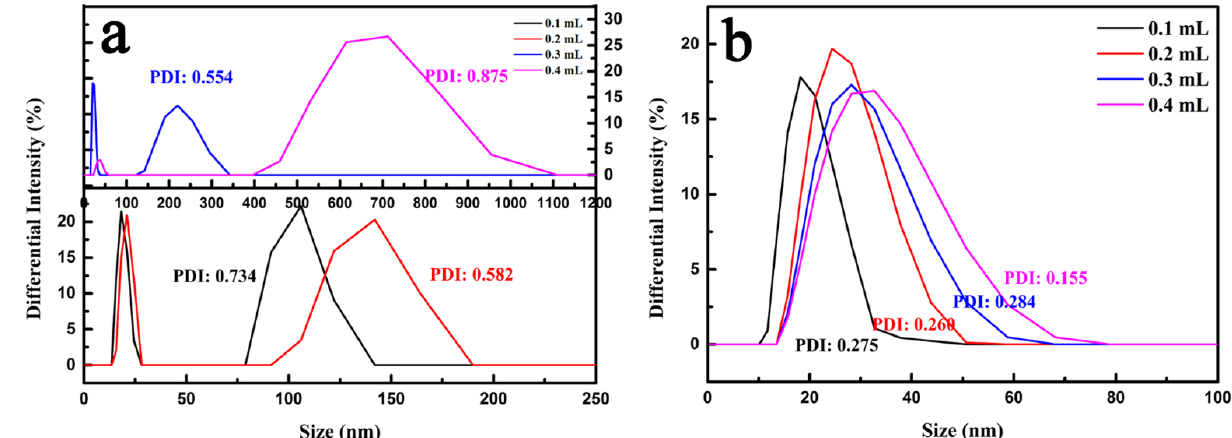
Figure 2. The DLS profiles of the primary emulsion ( a ) and secondary emulsion ( b ).